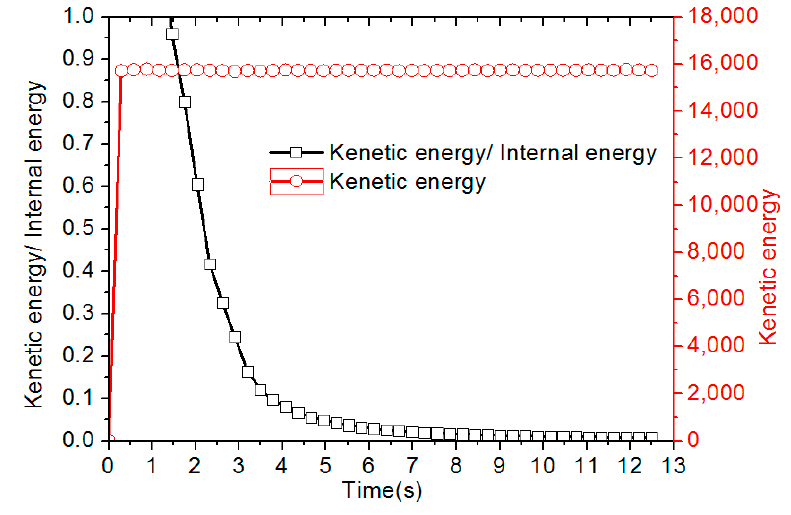
Figure 6. Energy evaluated of finite element model for forward tube spinning of 3A21 ‐ O aluminum alloy.